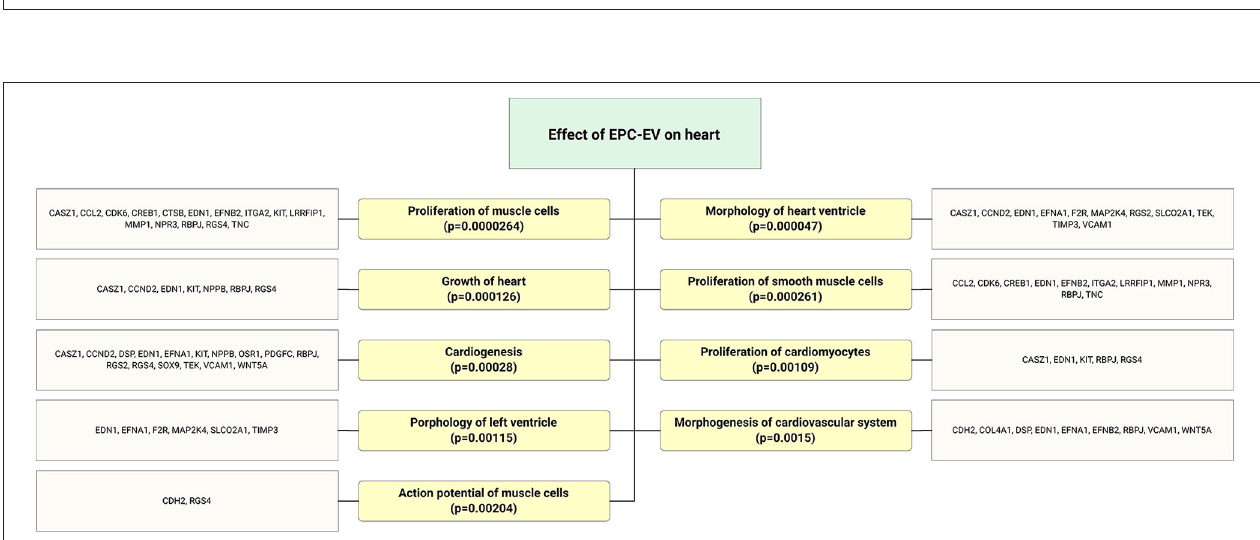
FIGURE 4 | As shown in the flow chart that highly expressed ECFC-EC-derived miRs biological targets were predicted in silico . The most significantly enriched functional annotation were Angiogenesis, vasculogenesis, and lymphangiogenesis. This miR sequence data was generated from PMID: 28631889. MicroRNA target genes were predicted using IPA with information from TargetScan, miRecords, and TarBase databases.